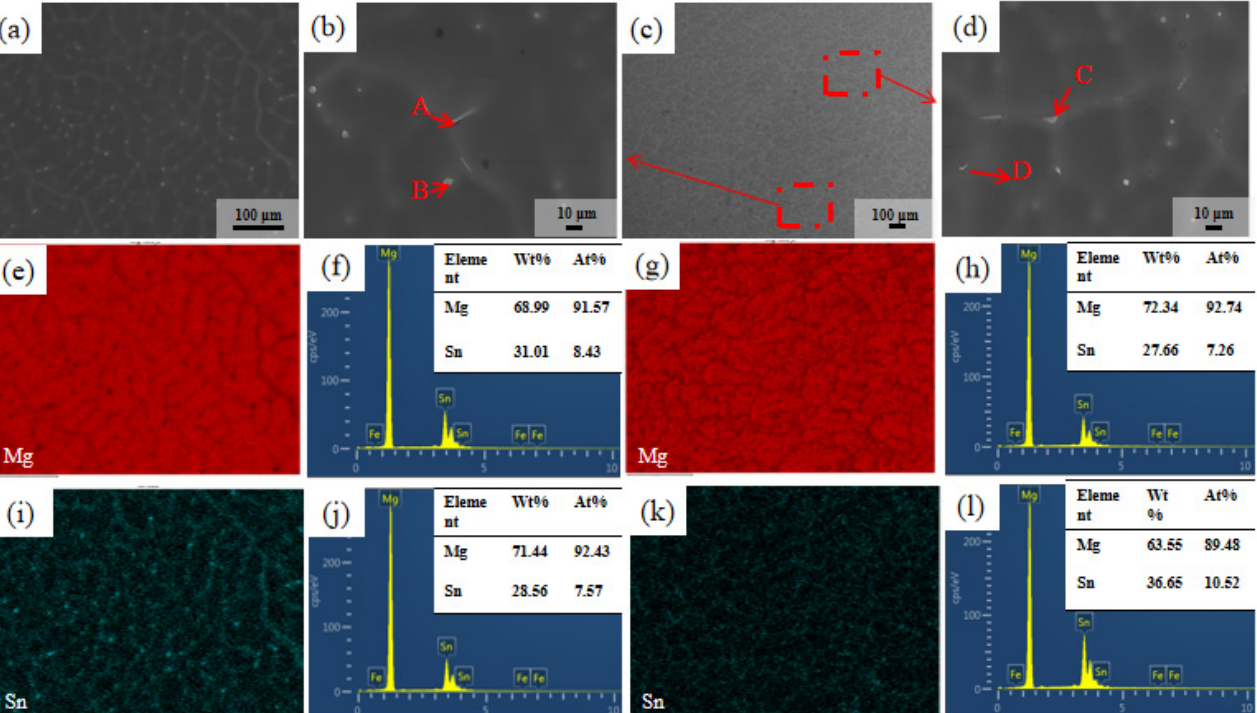
Figure 2. XRD patterns of the investigated alloys: ( a ) Mg-0.5Sn, ( b ) Mg-1Sn, ( c ) Mg-2.5Sn and ( d ) Mg-4Sn.